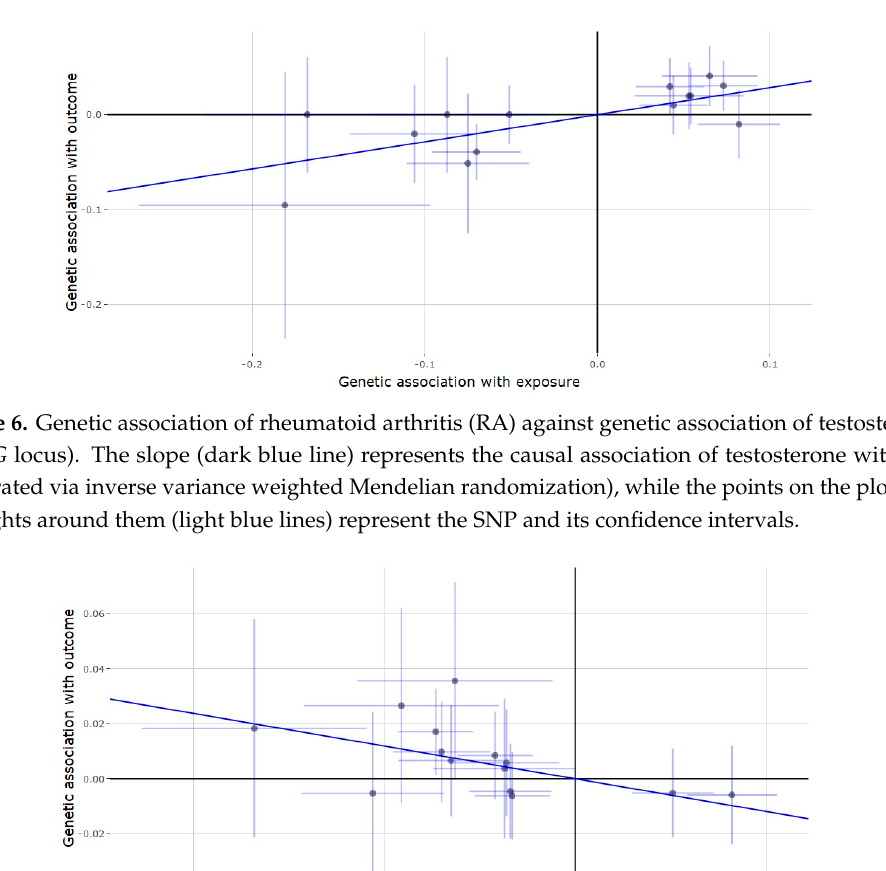
Figure 4. Genetic association of depression against genetic association of testosterone ( SHBG locus). The slope (dark blue line) represents the causal association of testosterone with depression (generated via inverse variance weighted Mendelian randomization), while the points on the plot and the lights around them (light blue lines) represent the SNP and its confidence intervals. Genes 2020 , 11 , 721